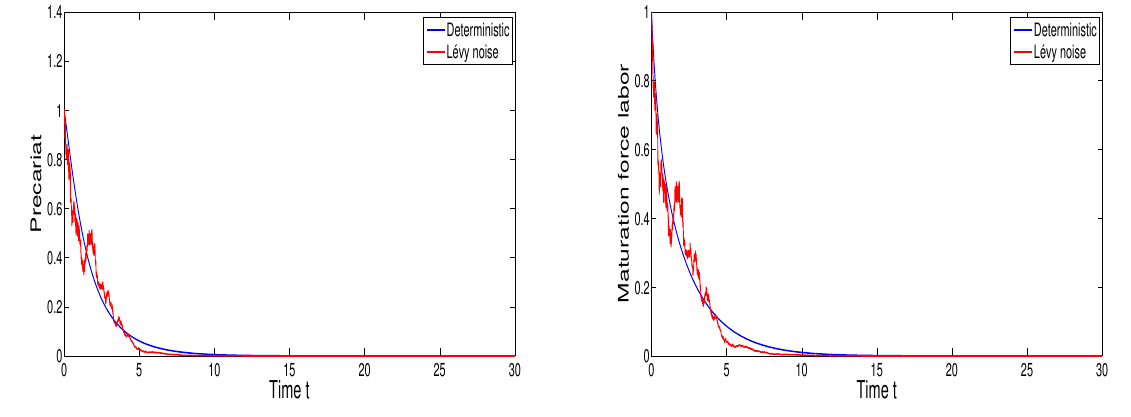
Figure 2. The behavior of free jobs and the labor force.